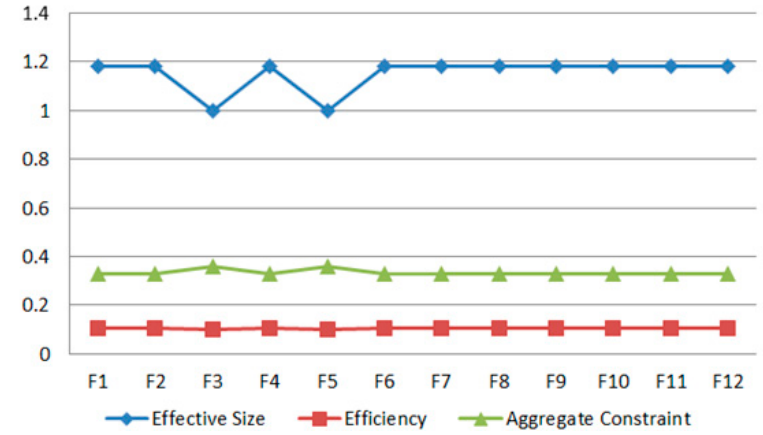
Figure 4. Structural holes for the barrier network.